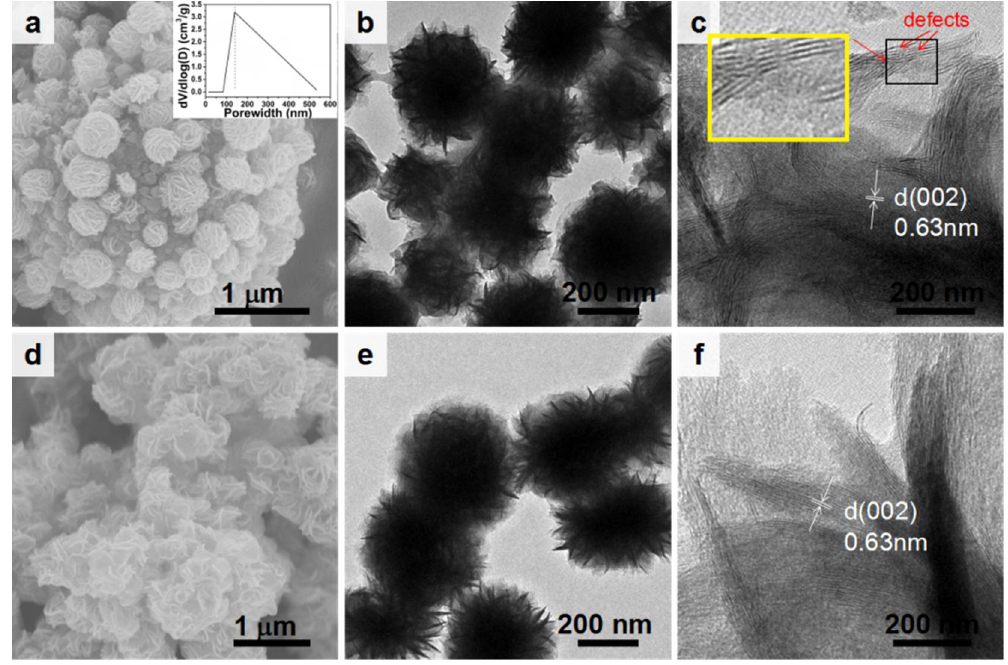
Figure 1. Scanning electron microscopy (SEM) images of ( a ) ZT-MoS 2 and ( d ) P-MoS 2 ; transmission electron microscopy (TEM) images of ( b ) ZT-MoS 2 and ( e ) P-MoS 2 ; high-resolution TEM (HRTEM) images of ( c ) ZT-MoS 2 and ( f ) P-MoS 2 . Inset a: porous size analysis of ZT-MoS 2 .